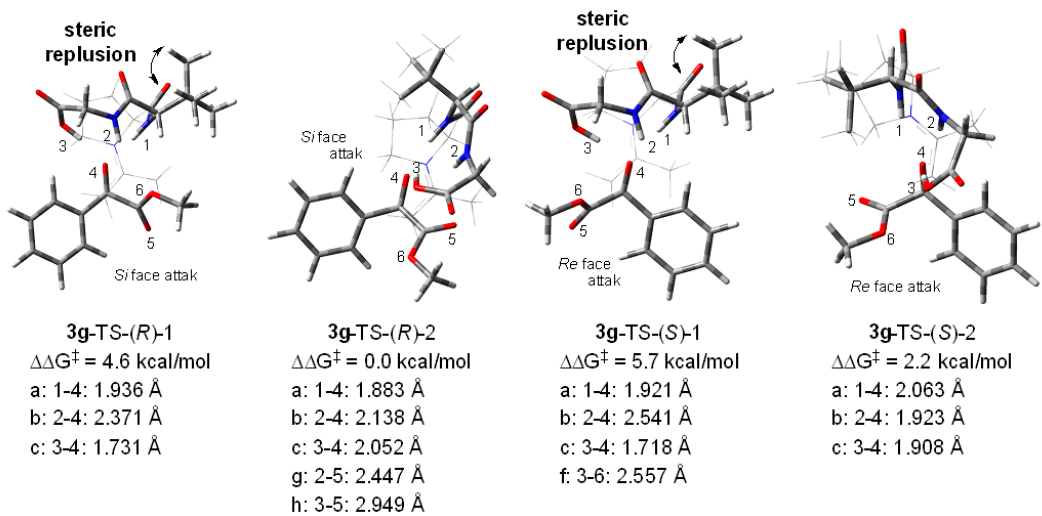
Figure 3. Transition states of C–C bond forming step of 3g -catalyzed reaction between 1a and 2 . All calculations were carried out via CPCM(acetone) / B3LYP / 6-31G(d’,p’) // B3LYP / 6-31G(d’,p’) level of theory.